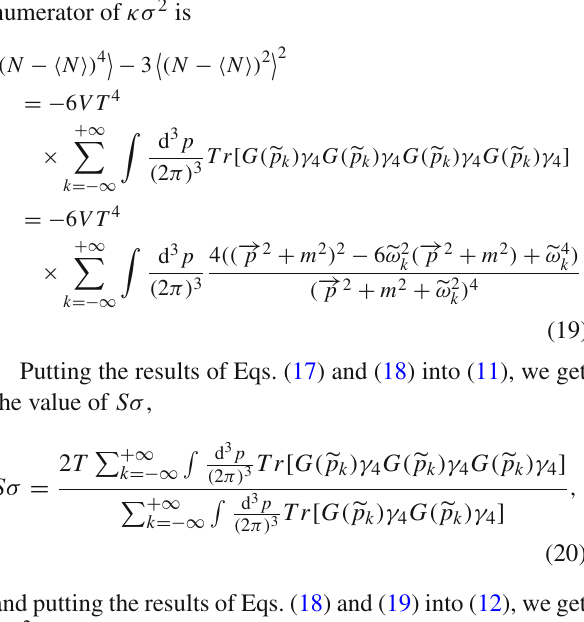
The Feynman diagram for